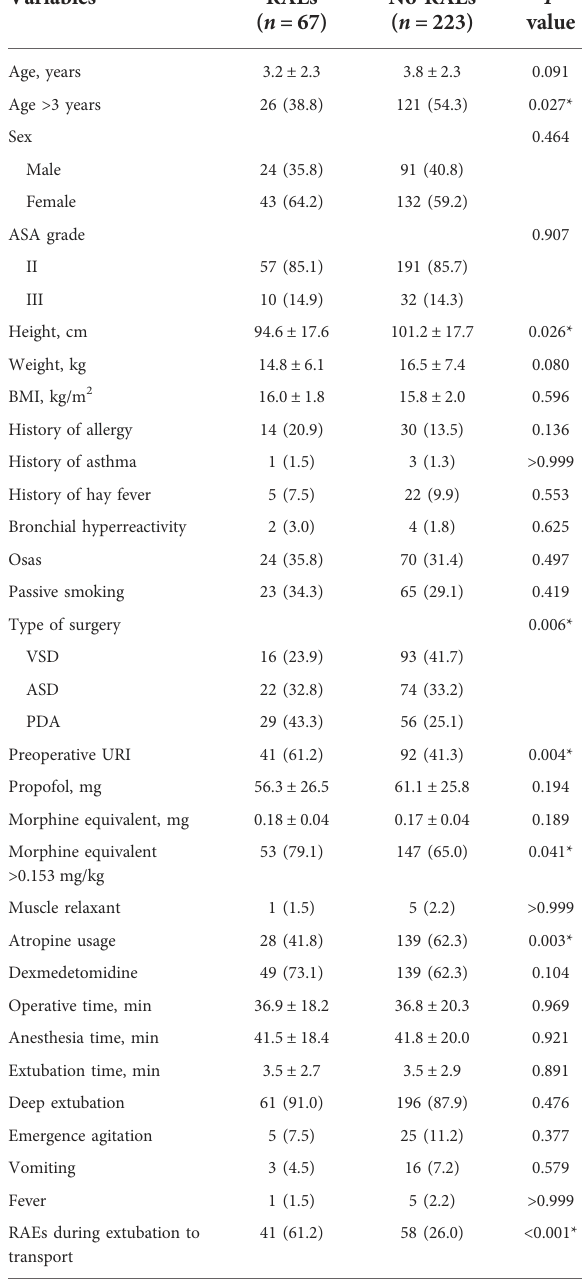
TABLE 1 Perioperative characteristics strati fi ed by RAEs during